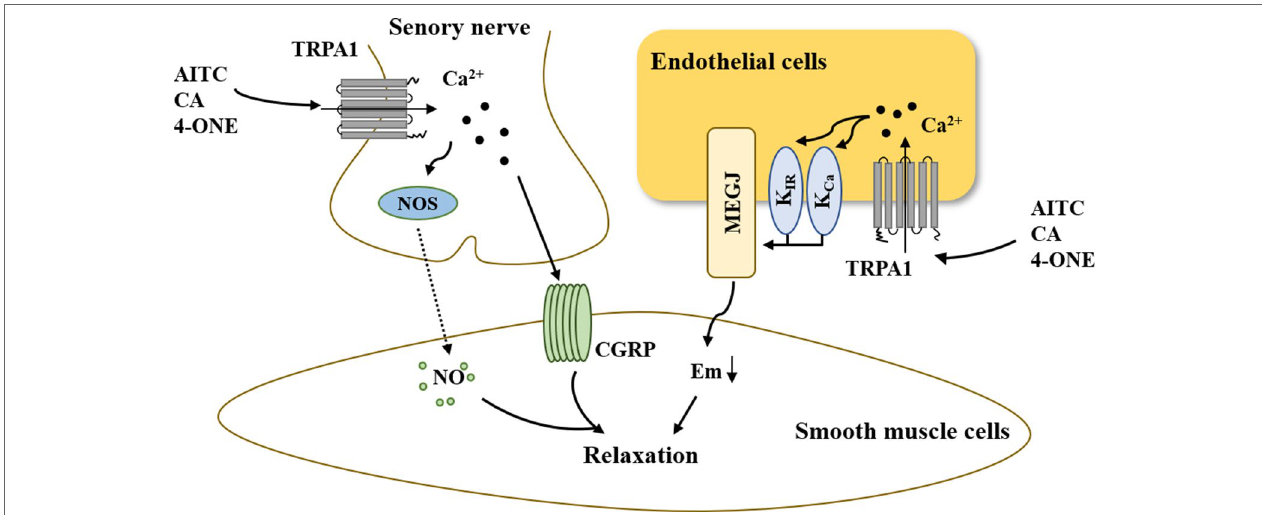
FIGURE 3 | The role of TRPA1 in vasodilation. On the one hand, increased Ca 2+ influx via TRPA1 activation results in hyperpolarization of the endothelial cell plasma membrane. The change in membrane potential is occurs to hyperpolarize the vascular smooth muscle cell plasma membrane, resulting in myocyte relaxation. On the other hand, the activation of TRPA1 in sensory neurons induces an increase in [Ca 2+ ] i , leading to the release of the neuropeptide CGRP and NOS-derived NO, thus mediating vasodilation. AITC, allyl isothiocyanate; CA, cinnamaldehyde; 4-ONE, 4-oxo-2-nonenal; CGRP, calcitonin gene-related peptide; NOS, nitric oxide synthase; NO, nitric oxide; K Ca , Ca 2+ -activated K + channel; K IR , inwardly rectifying K + channel; MEGJs, myoendothelial gap